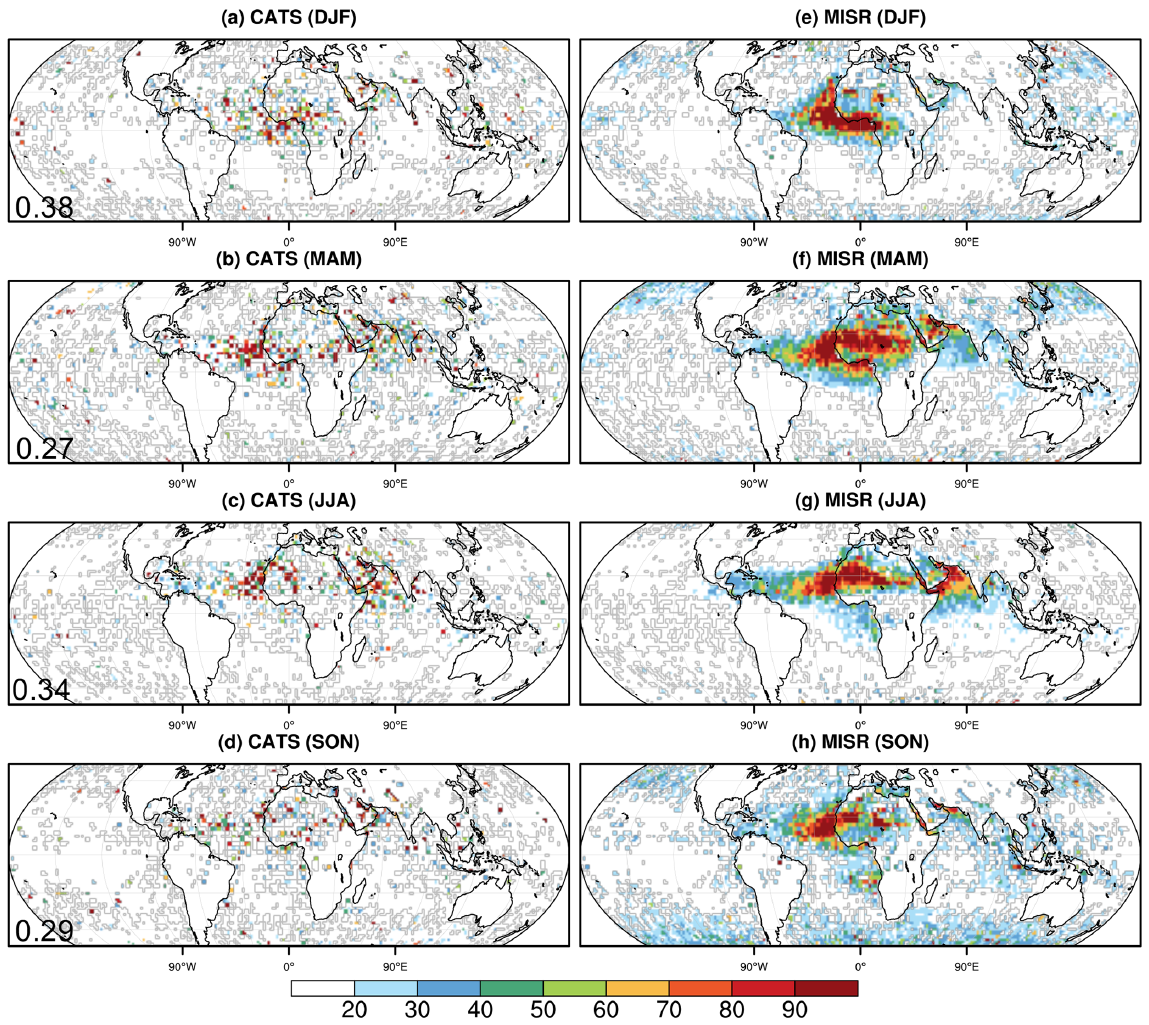
Figure 2. Comparison of seasonal-average, standardized, local morning DAOD from (a–d) CATS (1064nm) during 08:00LT to noon and (e–h) MISR (550nm) around 10:30LT in (a, e) December–February (DJF), (b, f) March–May (MAM), (c, g) June–August (JJA), and (d, h) September–November (SON) during 2015–2017. For a direct comparison, DAOD from each instrument in each season is standardized, namely divided by the 95th percentile of all DAOD observations between 51 ◦ N and 51 ◦ S from that instrument in that season and multiplied by 100. The spatial rank correlation between the seasonal DAOD maps from CATS and MISR is indicated in the corresponding CATS